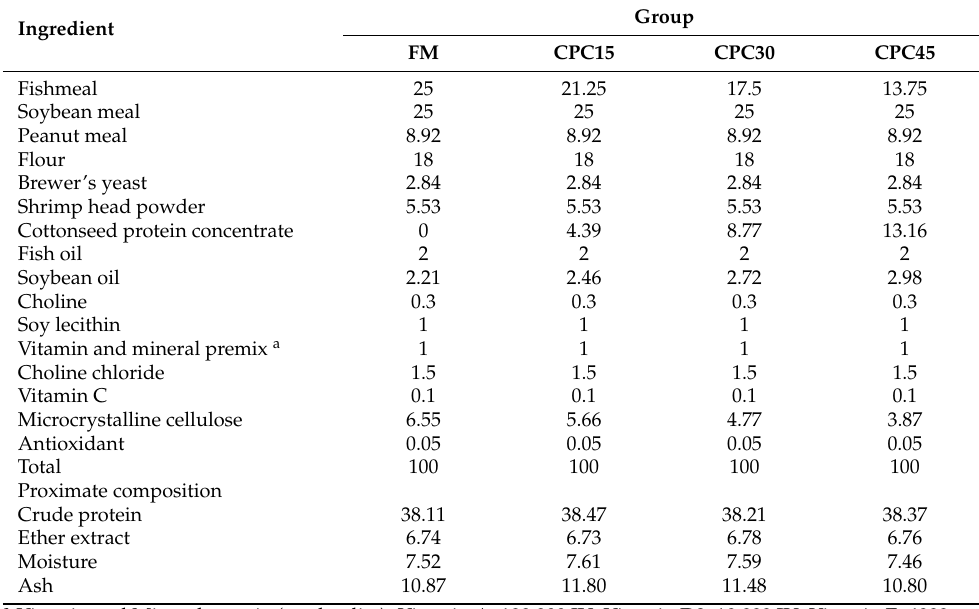
Table 1. Formulation and proximate composition of the experimental diets (Air dry basis, %).